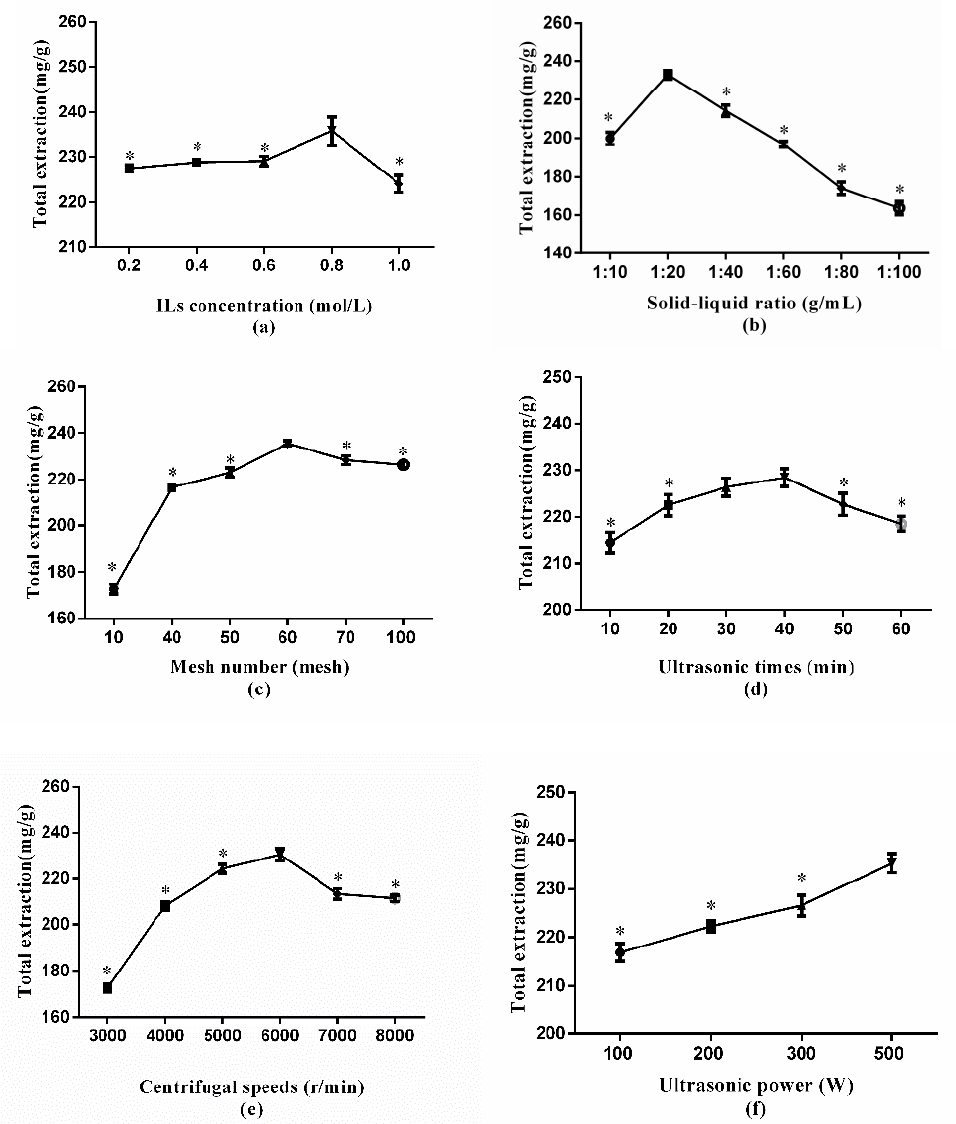
Figure 5. Extraction yields of ionic liquids-based ultrasonic assisted extraction (IL-UAE) affected by ( a ) ILs concentration temperature, when compared with 0.8 group: * p < 0.05; ( b ) solid–liquid ratio, compared with 1:20 group: * p < 0.05; ( c ) mesh number, compared with 60 group: * p < 0.05; ( d ) ultrasonic time, compared with 40 group: * p < 0.05; ( e ) centrifugal speeds, compared with 6000 group: * p < 0.05 ; ( f ) ultrasonic power, compared with 500 group: * p < 0.05.